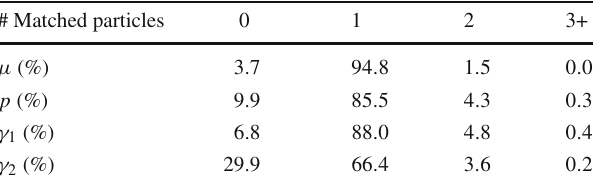
Table 3 Pattern-recognition performance for the target muon, proton andtwophotons( γ 1 isthephotonwiththelargestnumberoftruehits, γ 2 has fewer true hits) in simulated BNB CC ν μ interactions with resonant neutral-pion production. The total number of events was 17,939 and 49.9% had exactly one reconstructed particle matched to each